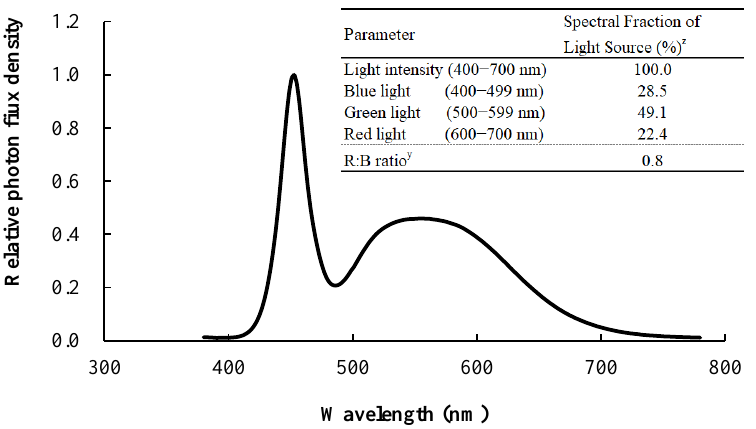
Figure 1. Relative photon flux density of the supplementary light source (white light emitting-diodes) used in the experiment. z Data are photon flux-based fractions of blue, green, and red lights. y R:B ratio, red light to blue light ratio.